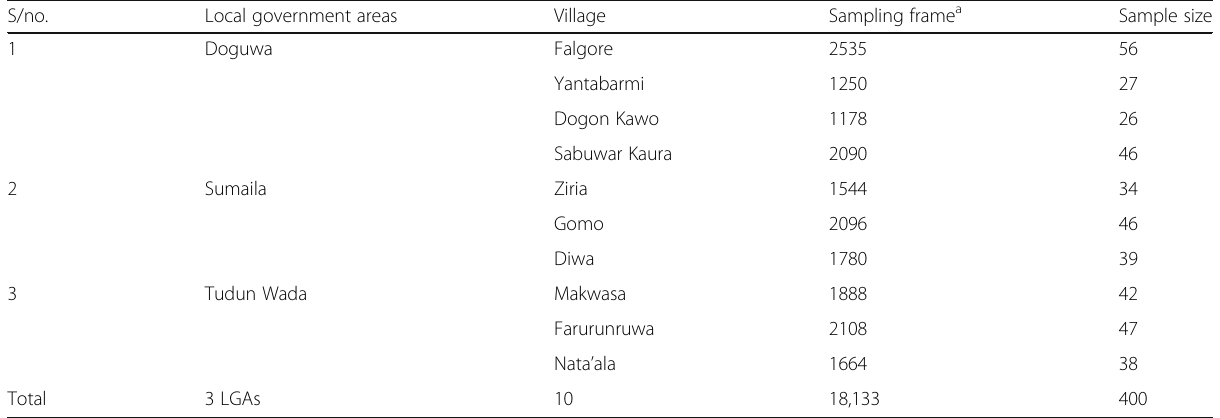
Table 1 Sampling frame and sample size